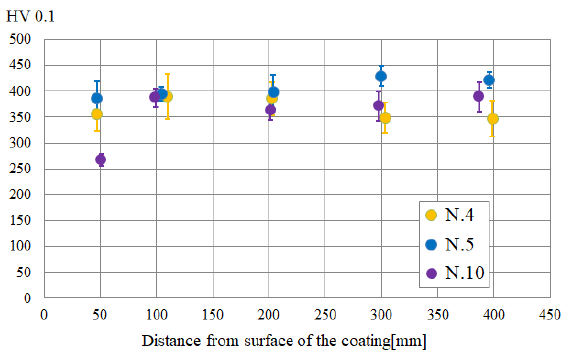
Figure 2. Results of HV0.1 indentation as a function of distance from surface.